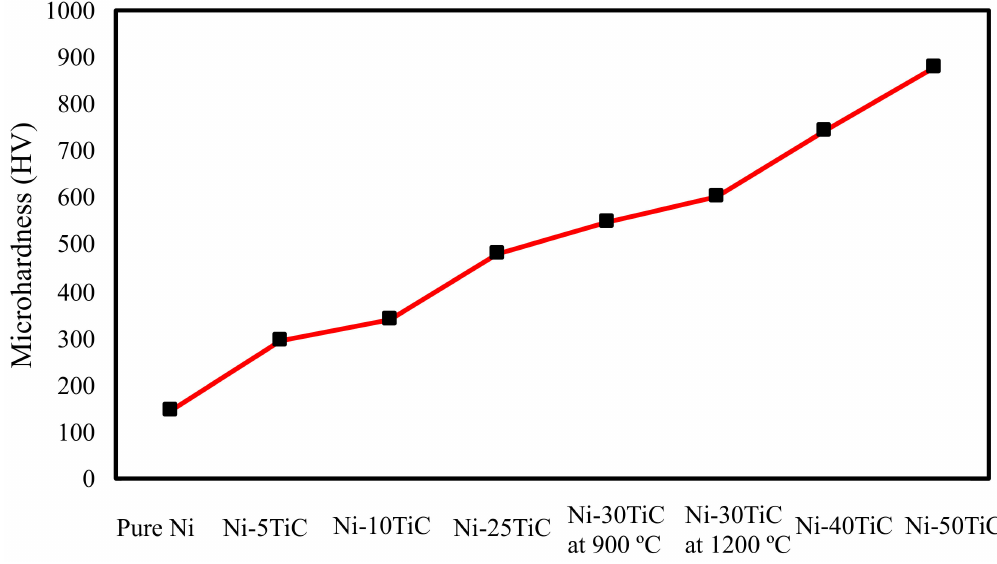
Figure 5. Microhardness of Pure Nickel and Ni-TiC